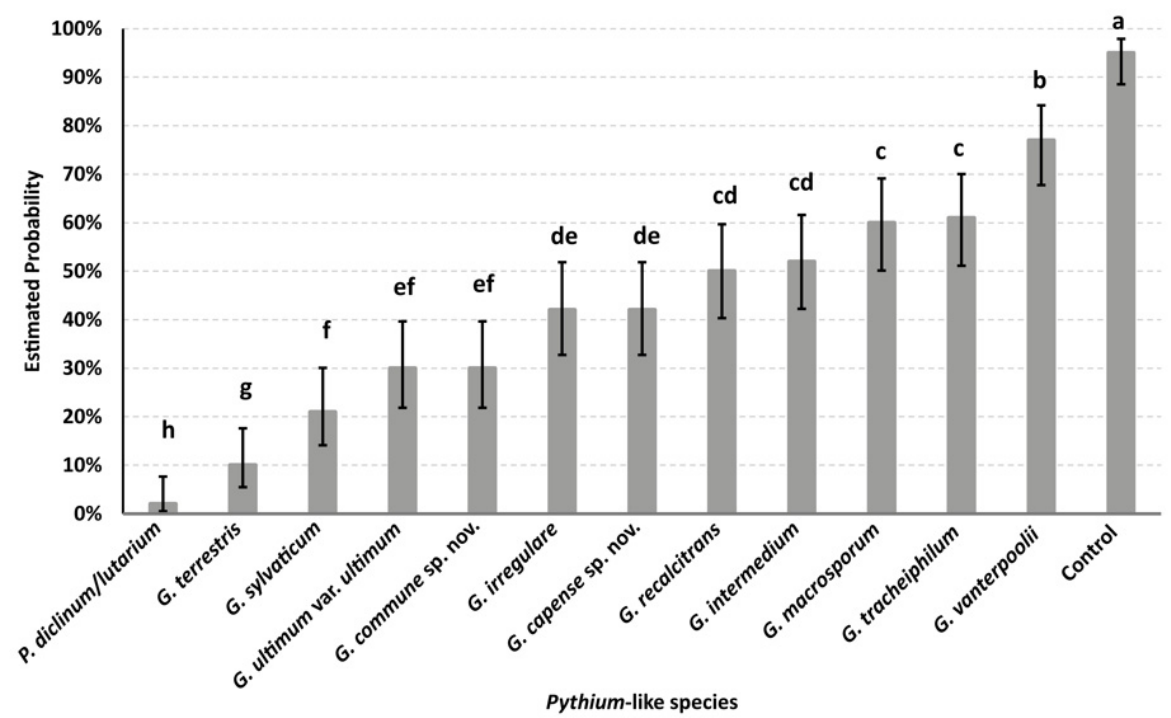
Figure 7. Predicted probability of pyrethrum seed germination inoculated with Pythium and Glo- bisporangium species, as calculated by the binary logistic regression model. Error bars indicate 95% confidence limit. Groups that do not share the same letter are significantly different by combination of odds ratios with 95% Wald con fi dence limits.